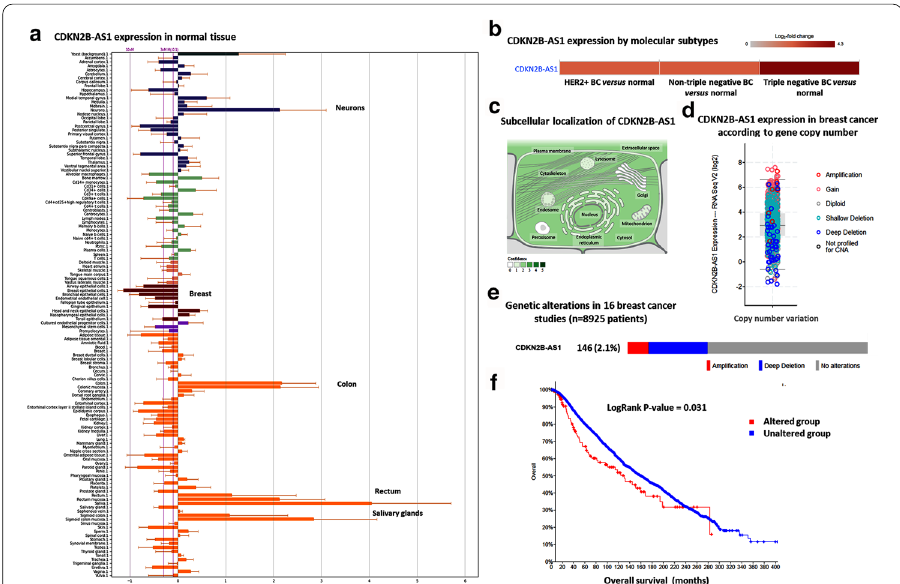
Fig. 6 CDKN2B-AS1 expression in normal and cancer states. a lncRNA expression in 27 normal tissues from GTEx Portal showed upregulation of CDKN2B-AS1 in colorectal tissue and salivary glands followed by neurons while being down-regulated in breast tissue. b Expression level of lncRNA in breast cancer tissues with different receptor status. c Subcellular localization of CDKN2B-AS1. d – f Analysis of 8925 breast cancer patients in the TCGA across 16 studies. d Expression level of CDKN2B-AS1 according to the gene copy number. e One hundred forty-six patients (2.1%) had a genetic alteration in the CDKN2B-AS1 gene (44 amplifications and 102 deep deletions). f Patients with altered CDKN2B-AS1 had poor survival